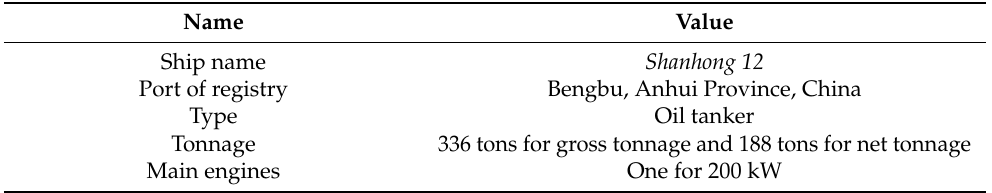
Table 1. Main technical data of